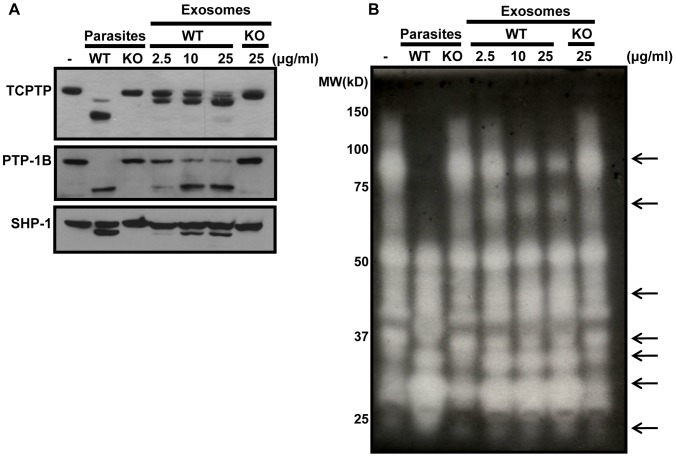
WT but not KO exosomes cleave macrophage PTPs dose-dependently.A. Western blotting shows that only WT but not KO parasites and exosomes can induce cleavage of prominent macrophage PTPs, TC-PTP, PTP-1B and SHP-1 after 3 h of incubation or infection. B. In gel PTP assay shows multiple modulations in the PTP profile of the macrophage following WT infection or incubation with WT exosomes, suggesting that cleavage fragments are enzymatically active. These modulations do not occur with KO parasites or with exosomes. All results are representatives of at least 3 independent experiments.